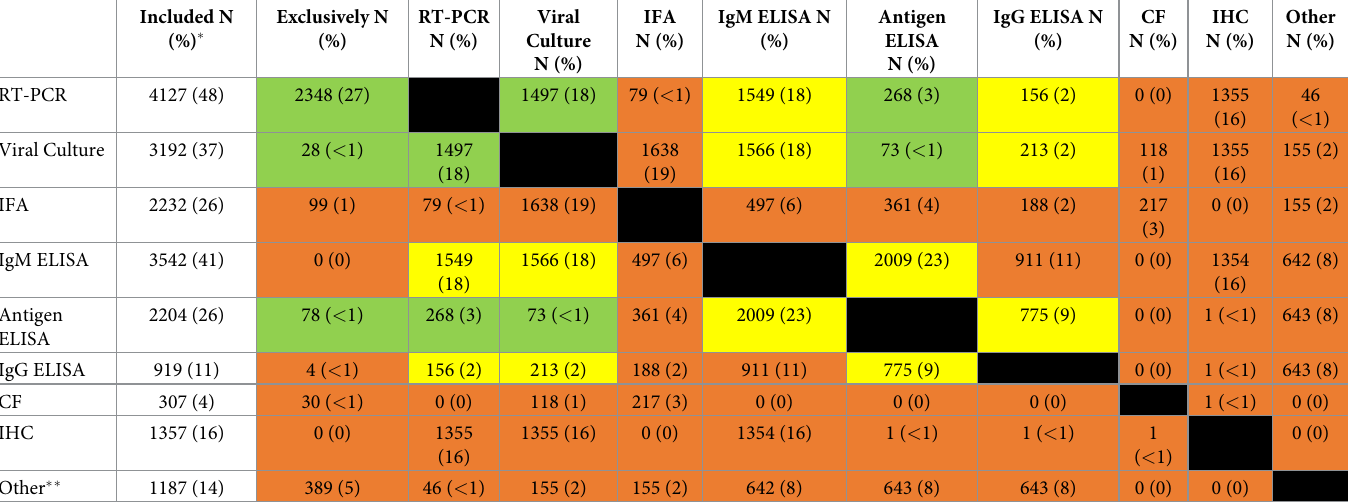
Green = high confidence of acute LF infection; Yellow = moderate confidence; Orange = low confidence.